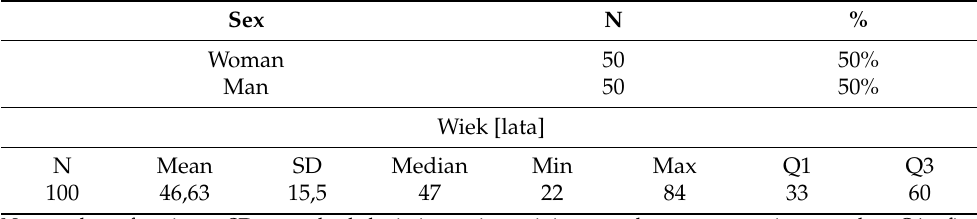
Table 1. Baseline